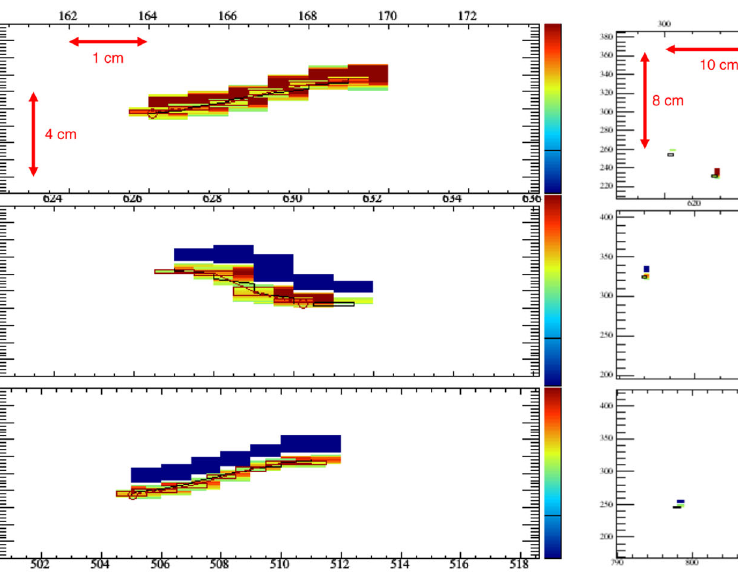
Fig. 4 Left: DUNE event display showing a simulated neutrino- electron ES event (10.25 MeV electron) with track reconstruction. The verticaldimensionindicatestimeandthehorizontaldimensionindicates wire number. Color represents charge. The top panel shows the collec- tion plane and the bottom panels show induction planes. The boxes